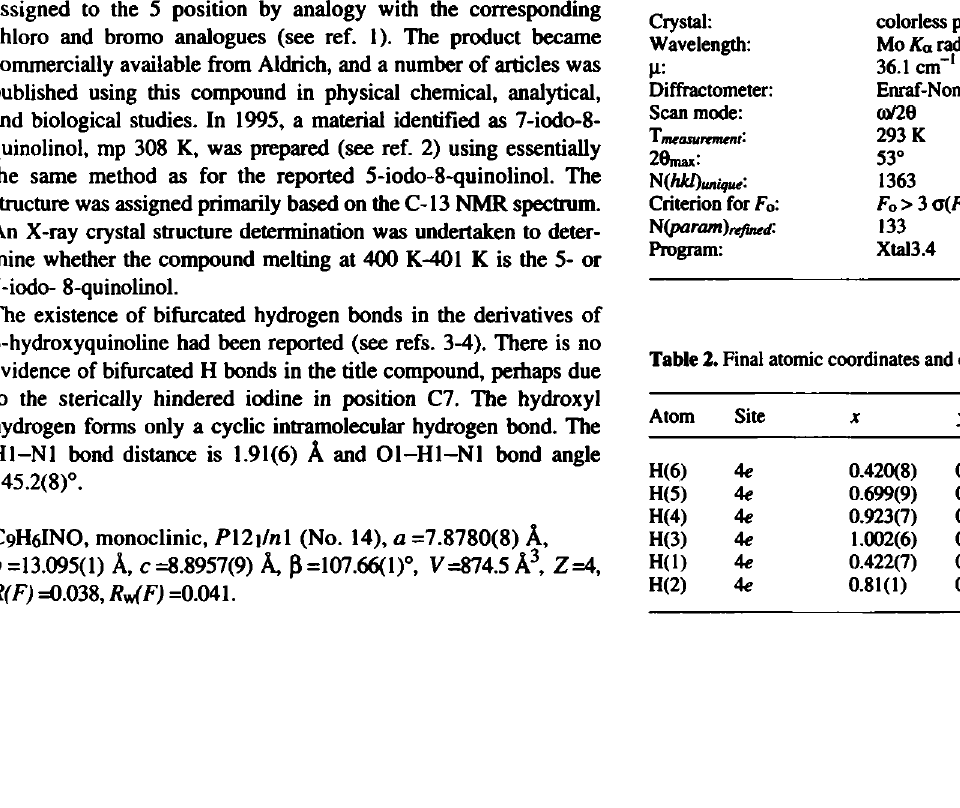
Fig. 2. Packing of the molecules viewed down the c axis. The hydrogen atoms have been omitted. Table 1. Parameters used for the X-ray data collection